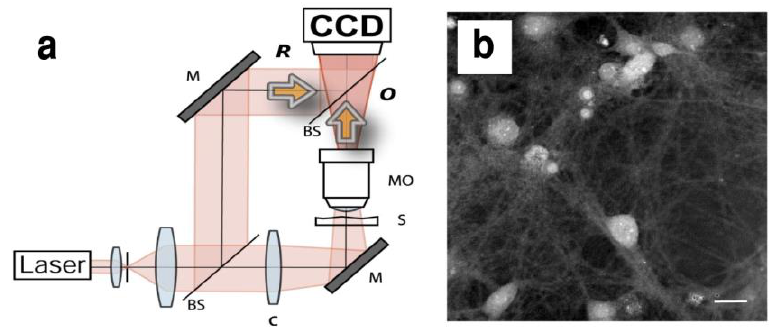
Figure 2. Digital holography microscopy (DHM) for exploring living neurons. ( a ) Quantitative-phase (QP)—DHM experimental setup. Beam splitter (BS), condenser (C), mirror (M), specimen (S), microscope objective (MO), object wave (O), reference beam (R) and digital CCD camera. ( b ) Representative example of quantitative-phase image of primary mouse cortical neurons, between 14 and 21 days in culture. Scale bar represents 25 µ m. Reprinted with permission from Elsevier [112].